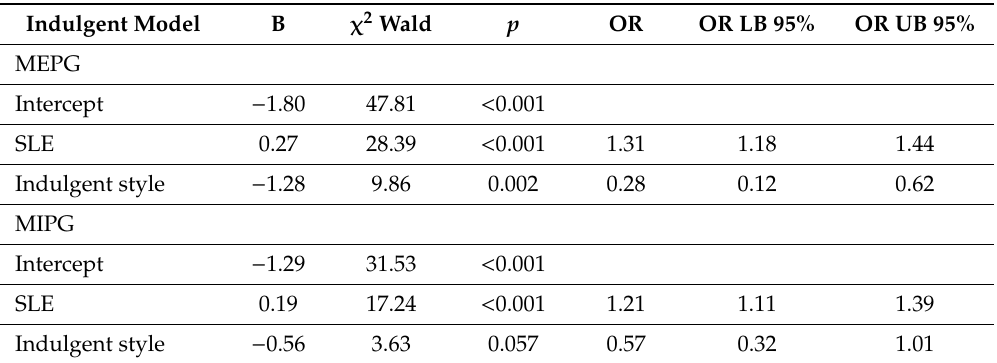
Table 5. Multinomial logistic regression model parameters using the AG as a reference and indulgent style as covariate.